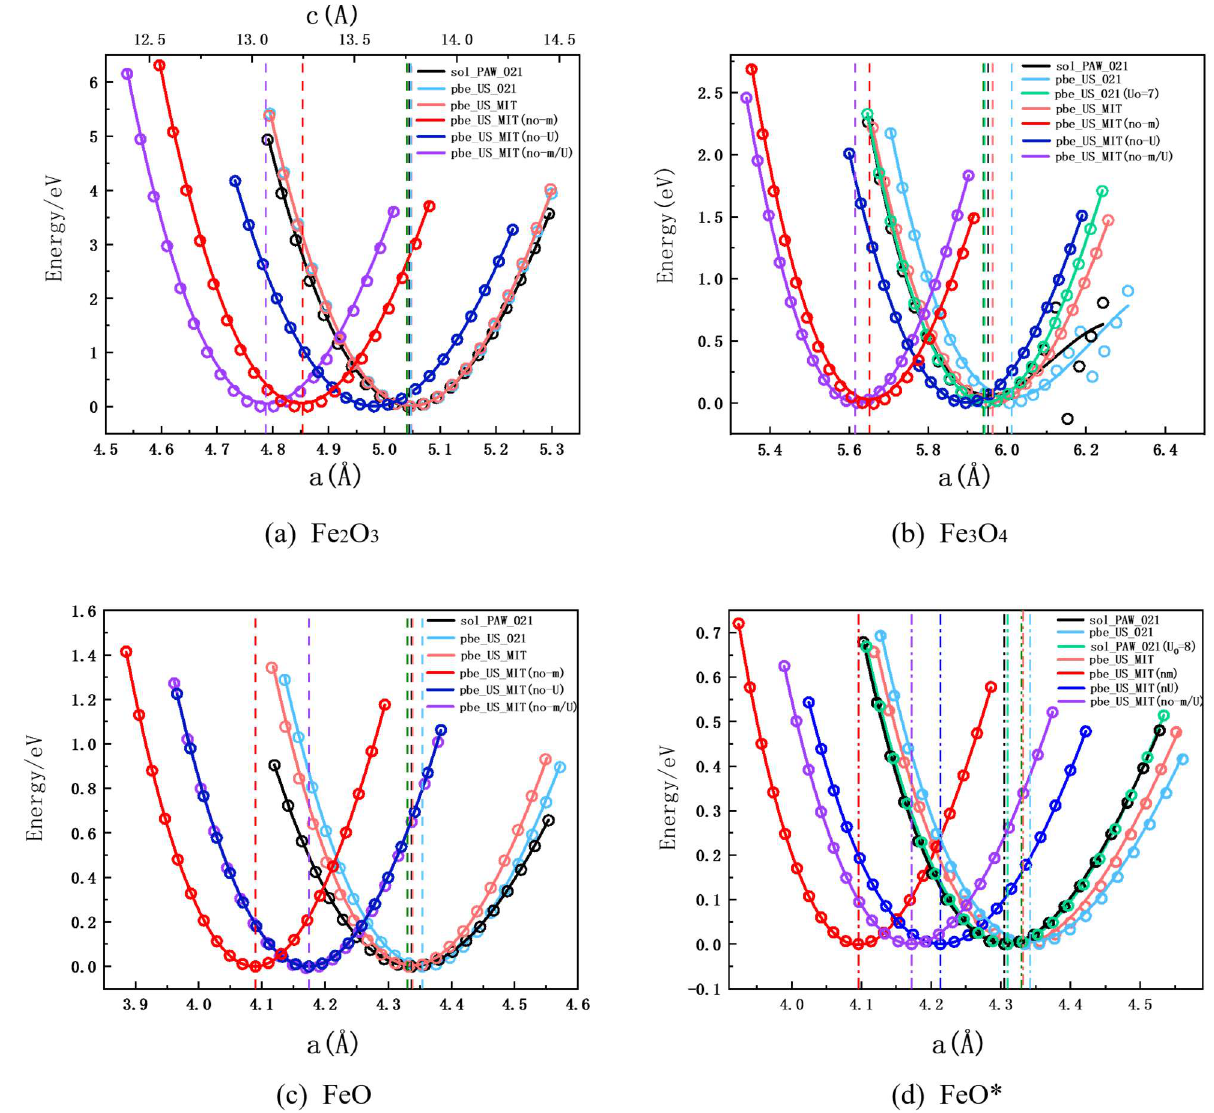
Figure 7. ( a – d ) are the equations of state of Fe 2 O 3 , Fe 3 O 4 , FeO, and FeO*, respectively. The circles represent the calculated data, and the lines corresponding to the colors are the fitting results by the Birch-Murnaghan equation of state. The dotted line is the V O obtained by the corresponding color line, and the dark green dotted line is the experimental value. Table 3. The bulk V 0 , bulk modulus B 0 , and first derivative of bulk modulus with respect to pressure B p of three iron oxides (including FeO *) at 0 pressure under different conditions by the Birch– Murnaghan equation of state. Bold is the result closest to the experimental value.